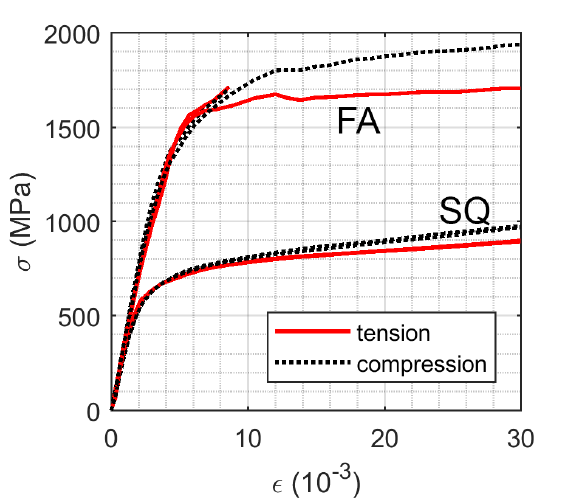
Figure 3. Stress-strain curves in tension and com- pression obtained from four point